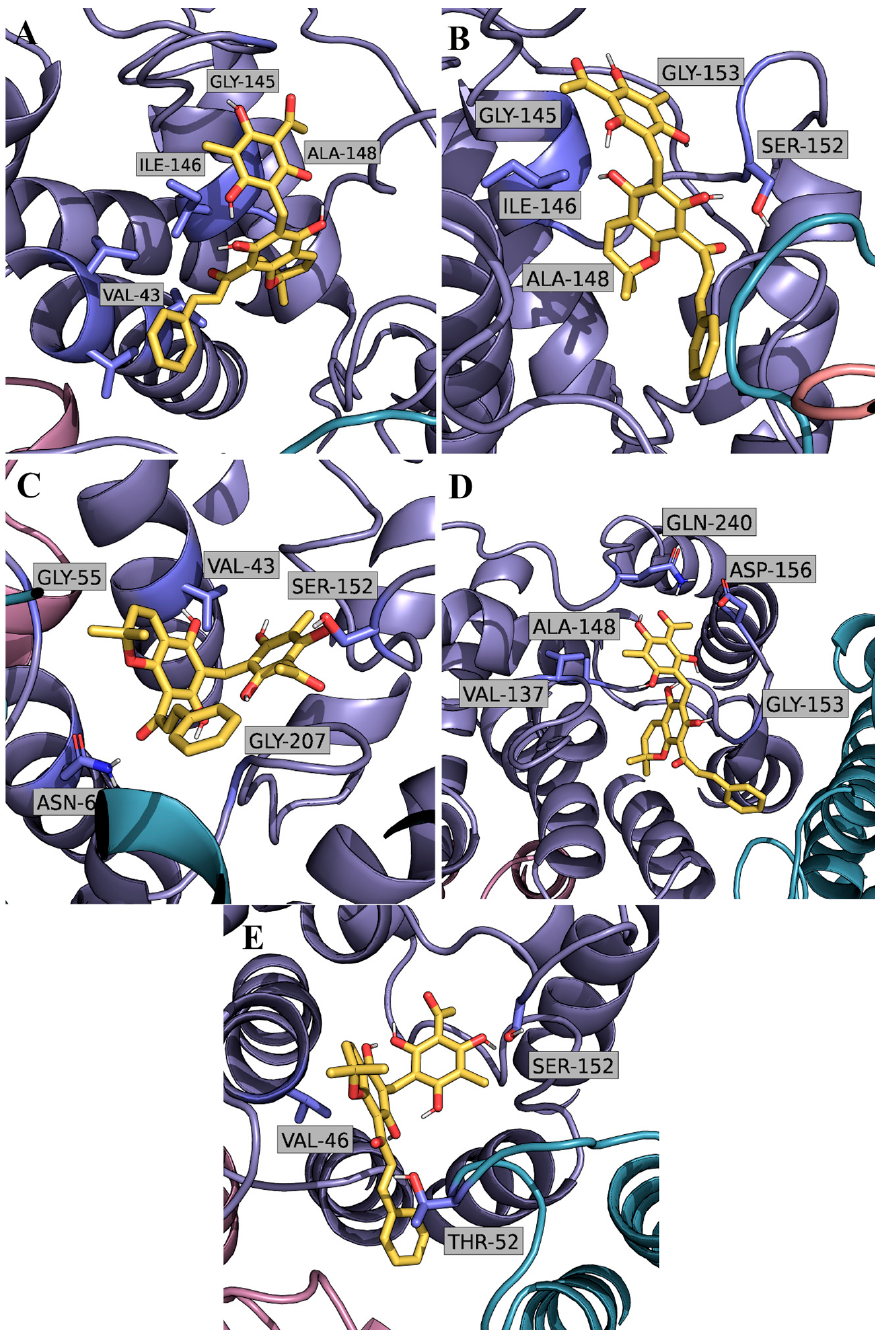
Figure 6. Representative molecular docking poses of RoT on the binding region of AQP3 taken from the used representative configurations from basin 1. ( A – E ) subfigures highlight the interactions established between RoT and AQP3 residues.